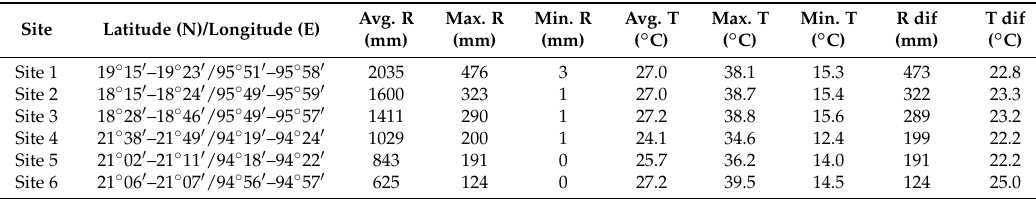
Table 1. Climatic variables of the study sites.